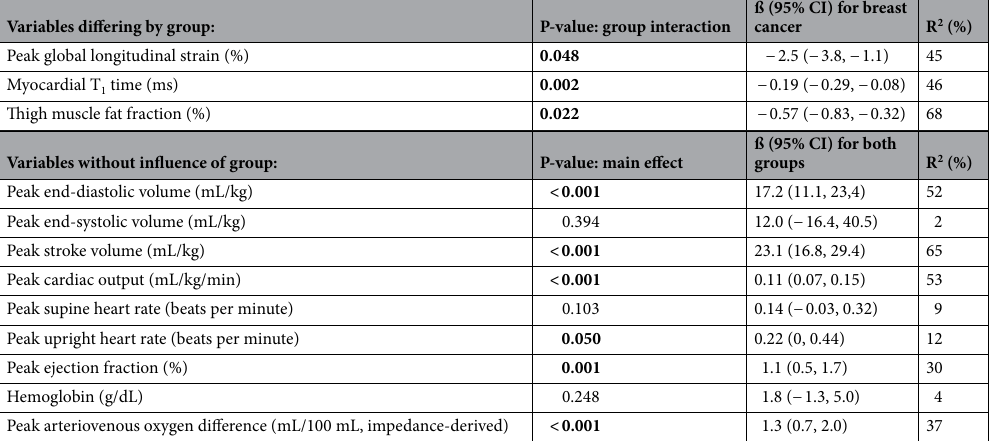
Table 3. Predictors of relative VO 2 peak (mL/kg/min) for breast cancer and matched controls combined (n = 32) with adjustment for group. Bolding indicates significance. ß unstandardized beta coefficient, CI confidence interval, R 2 coefficient of